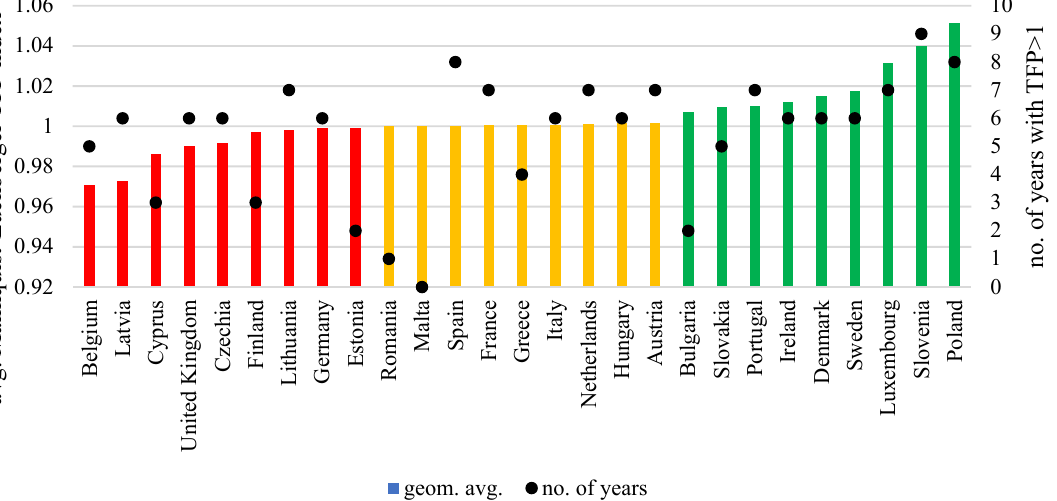
Figure 2. Average progress toward sustainable intensification in EU countries in the years 2006–2018. Source: the authors’ study based on the Malmquist TFP index and Eurostat data.